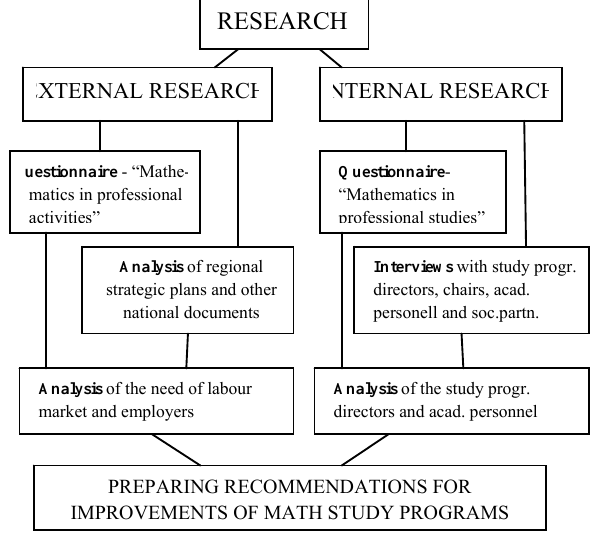
Figure 4. Areas of the project research